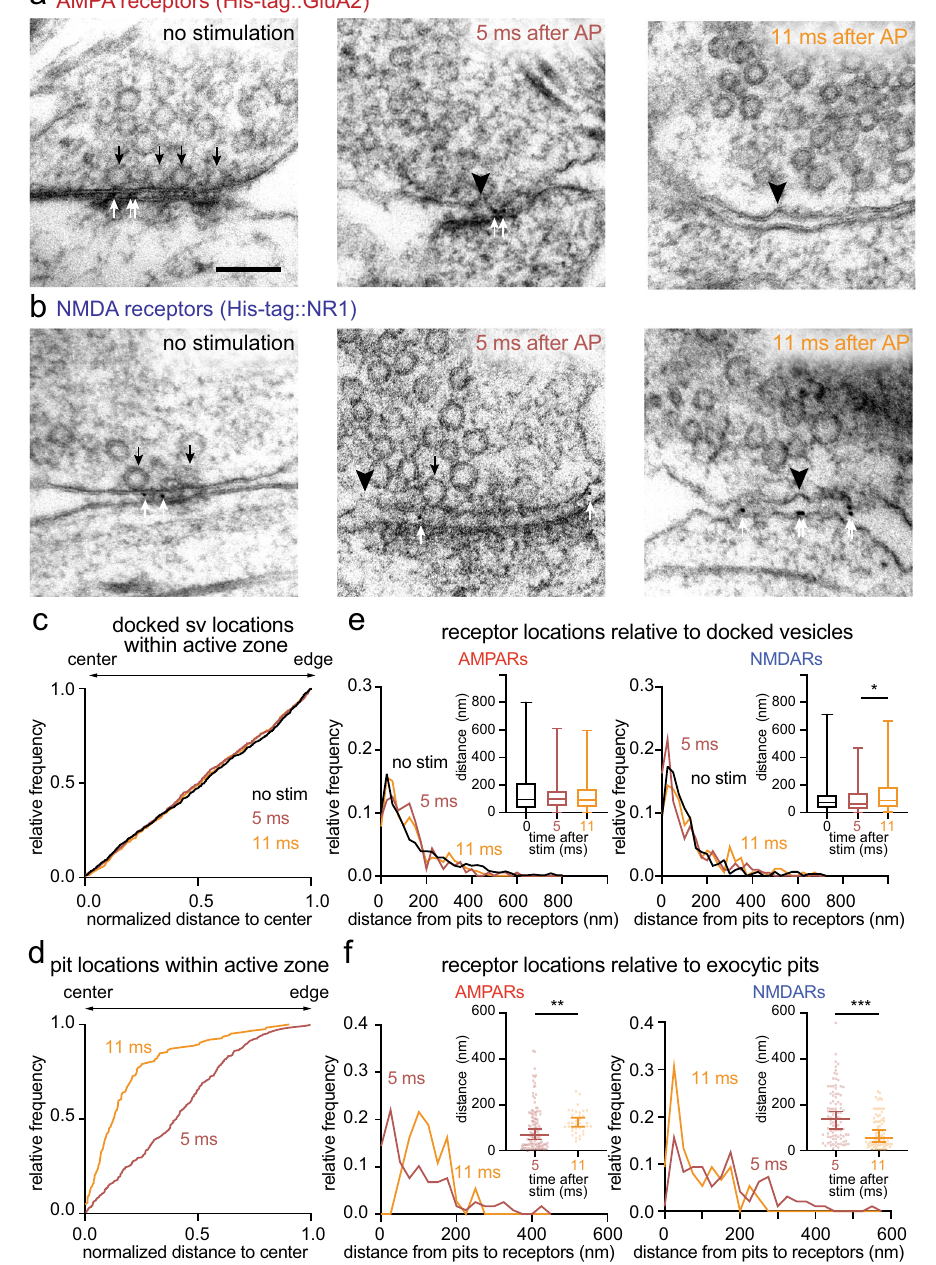
Fig. 3 Synchronous and asynchronous release are aligned to AMPA and NMDA receptors, respectively. Example transmission electron micrographs of synapses after SMASH labeling and high-pressure freezing at the indicated time points after an action potential (AP), showing pits (black arrowheads), docked vesicles (black arrows), and gold particles (white arrows) at synapses of wild-type neurons expressing His-tag::GluA2 ( a ) and His-tag::NR1 ( b ). Cumulative relative frequency distribution of lateral distances between docked vesicles ( c ) or exocytic pits ( d ) and the active zone center at 5 or 11 ms after stimulation, as measured within 2D pro fi les by transmission electron microscopy. Exocytic pits were biased toward the center both at 5 ms (median = 0.4, p < 0.001, n = 286 pits, N = 7 samples) and 11 ms (median = 0.13, p < 0.001, n = 124 pits, N = 7 samples), but pits at 11 ms were strongly biased toward the center ( p < 0.001, Kolmogorov – Smirnov D test). Bias of vesicles and pits locations toward the center or edge of the active zone in ( c , d ) was tested by comparing each group to a theoretical median of 0.5 using one-sample two-tailed Wilcoxon signed-rank tests. Relative frequency distribution of lateral distances between docked vesicles ( e ) or exocytic pits ( f ) and gold particles within the cleft at 5 ms (red) and 11 ms (orange) after stimulation. Insets: the same data plotted as box and whiskers for docked vesicles ( e ) and scattered dots for pits ( f ) to show the median distances. Error bars: median and 95% con fi dence interval for the scattered dot plots. Kolmogorov – Smirnov D tests were performed in each case, with additional post hoc Dunn ’ s multiple comparisons tests for docked vesicle data. * p < 0.05, ** p < 0.01, *** p < 0.001. Experiments were repeated three times independently. Scale bar: 100 nm. See Supplementary Data Table 1 for full pairwise comparisons and summary